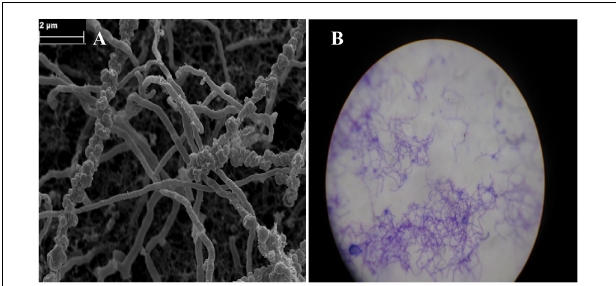
FIGURE 8 | Micro-morphological characteristic of Glycomyces sediminimaris UTMC 2460 on ISP2 medium after 10 days’ incubation at 28 ◦ C. (A) Scanning electron micrograph of spore chains of the strain (Bar, 2 µ m). (B) Filamentous vegetative mycelia under light